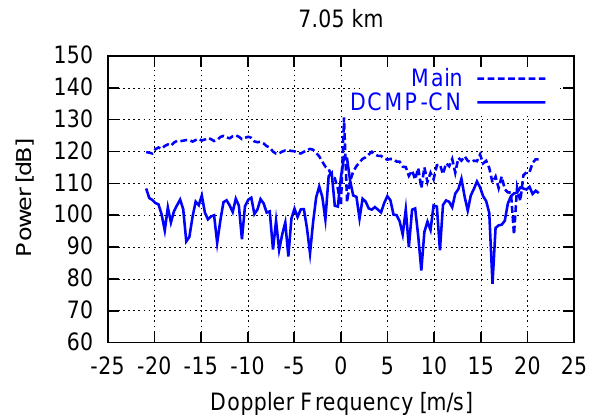
Fig. 7. Example of the Doppler echo power spectrum with strong aircraft echo at a sampling interval of 76ms from raw main beam data (dashed) and with proposed DCMP-CN algorithm (solid). The y-axis indicates received power in arbitrary units.